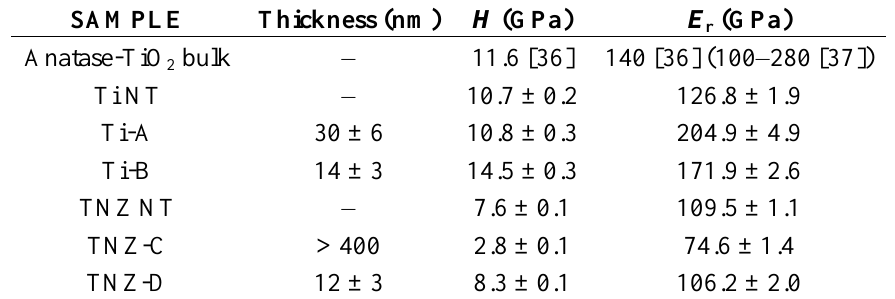
Table 3. Coatings thickness as obtained from AES; hardness ( H ) and reduced modulus of elasticity ( E ) as obtained from nano-indentation r